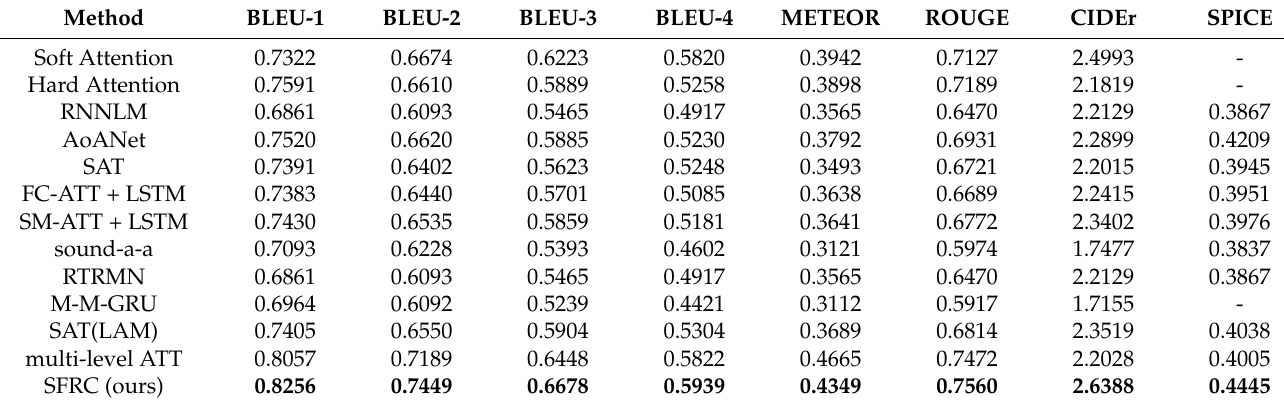
Table 2. Quantitative comparison results on Sydney-Captions